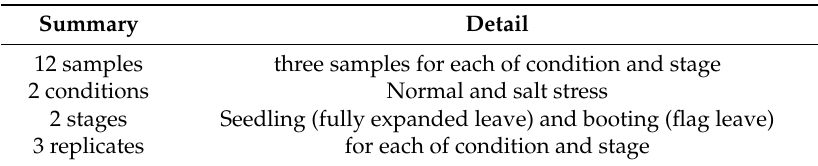
Table 1. Number of samples and